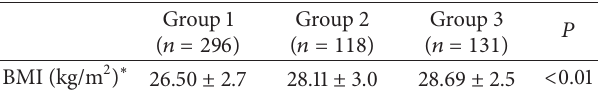
Table 2: Body mass index (BMI) of type 2 diabetic patients ( 𝑛 = 545 ) divided into three groups according to diabetic retinopathy status.